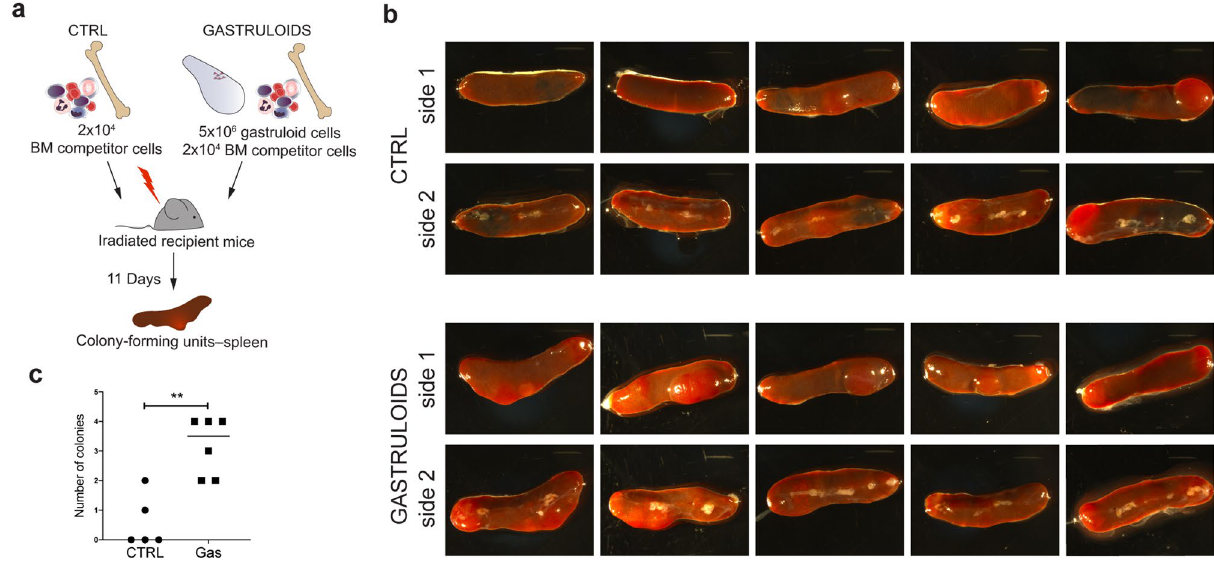
Figure 5. Gastruloid-derived cells form CFU-S upon transplantation. ( a ) Schematic overview of the transplantation strategy and analysis of CFU-S. ( b ) Stereomicroscope images of spleens from 5 different recipient mice imaged on both sides. ( c ) Quantification of the number of colonies observed in recipient mice transplanted with control cells or cells derived from Gata6-Venus gastruloids. Single data points are shown in graph. n = 5 control mice and n = 6 mice were injected with Gata6-Venus gastruloid cells. CTRL control, BM bone